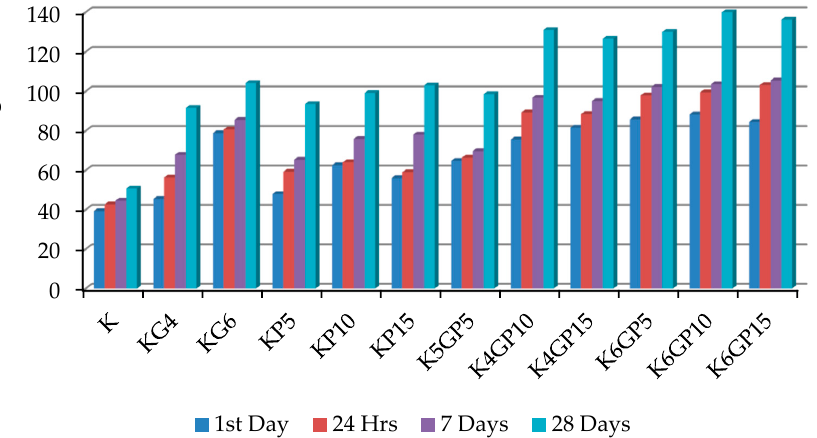
Figure 13. Stress-strain curve of kaolin and stabilized kaolin with gypsum and POFA at different curing times.